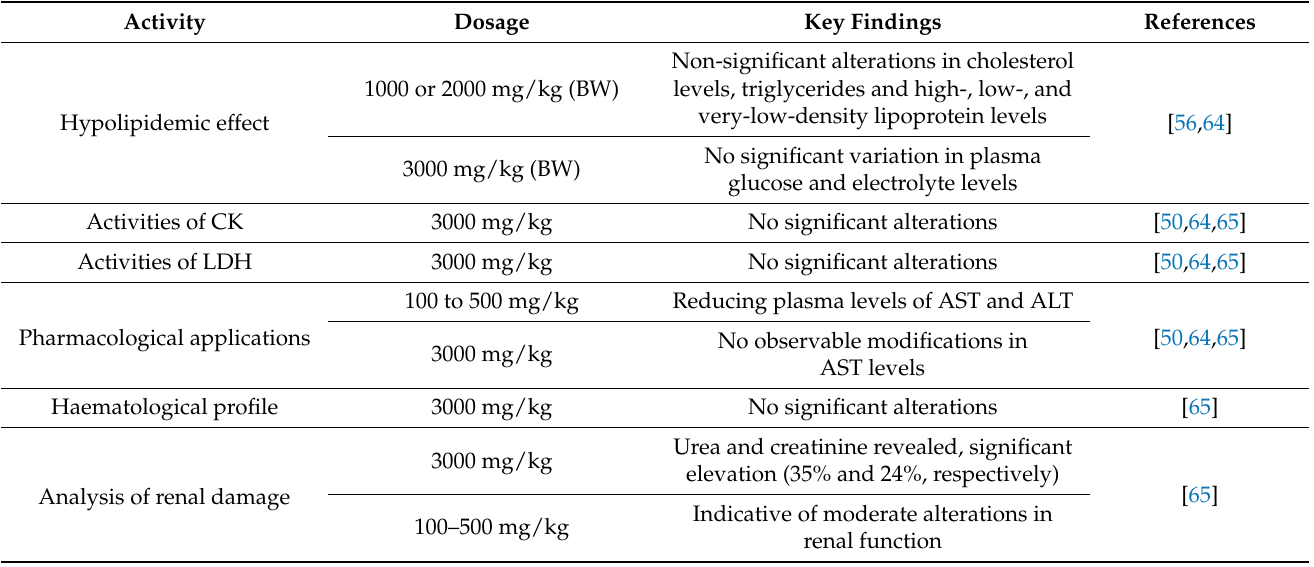
Table 4. Safety aspects of jamun